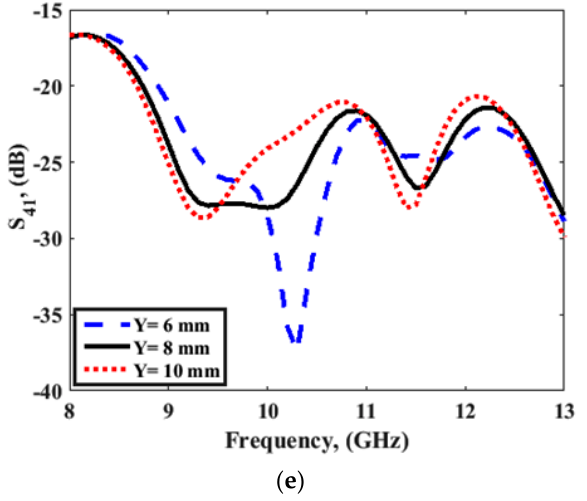
Figure 11. ( a ) S 11 parameter, ( b ) AR response, and ( c – e ) isolation between ports for 4-port MIMO configuration.